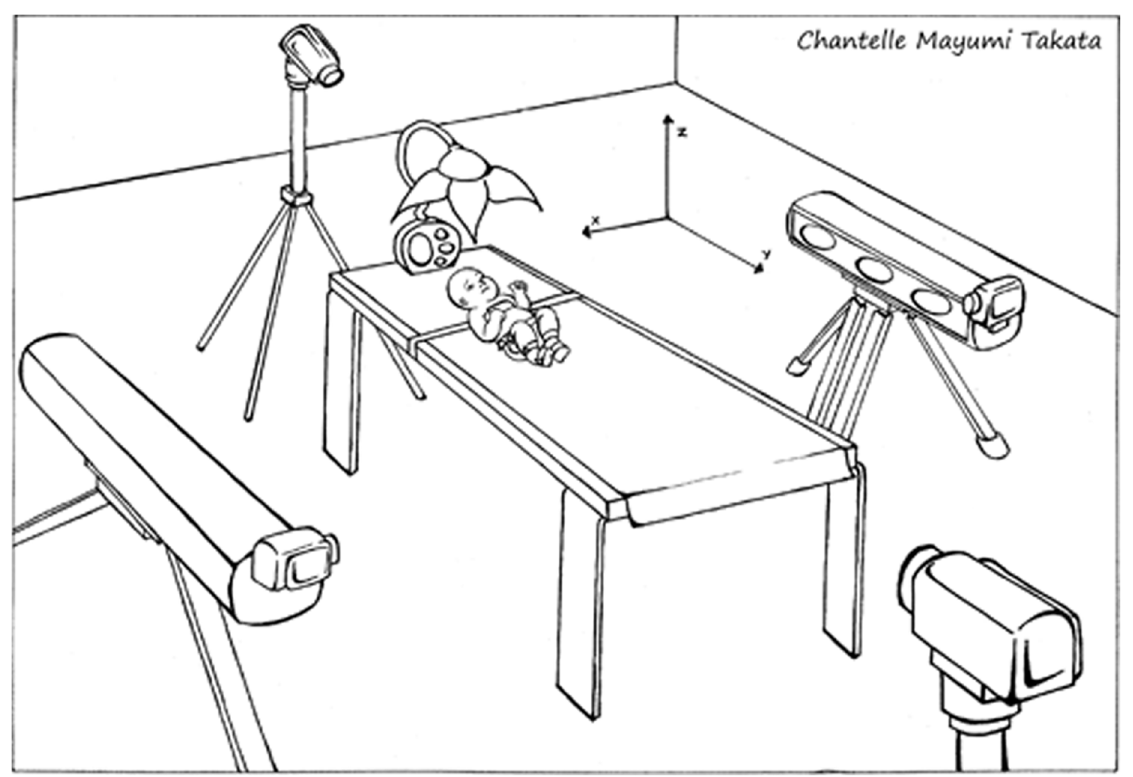
Figure 2. Infant mobile experimental set-up.